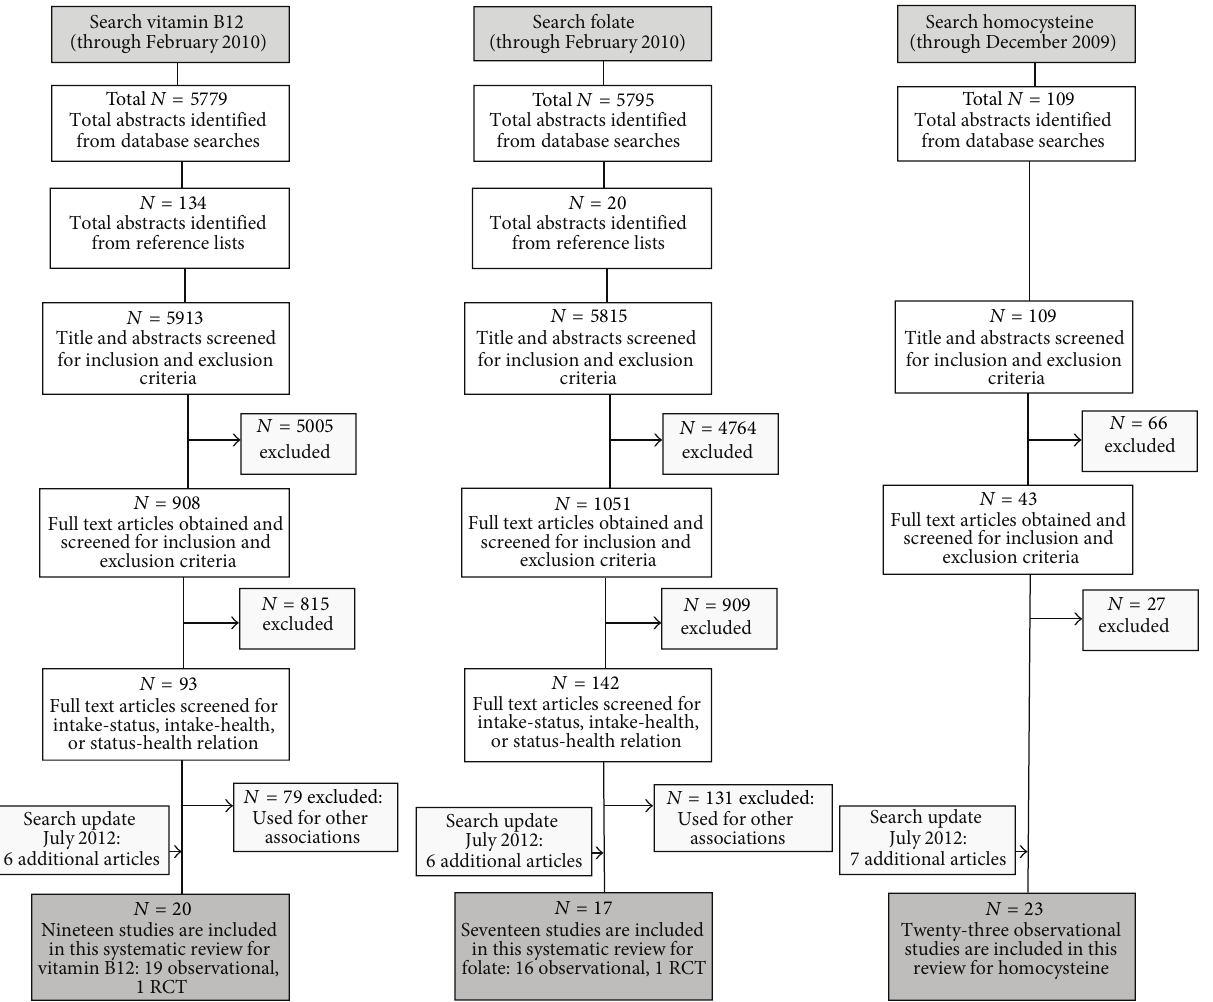
Figure 1: Flow diagram of screening and